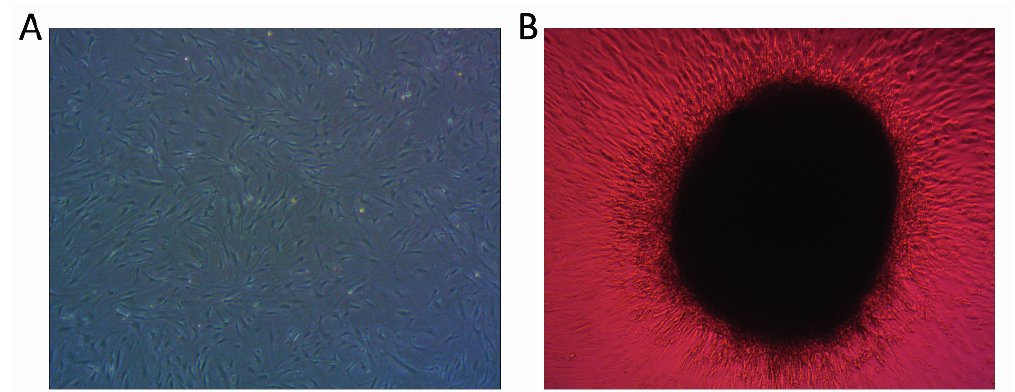
Figure 8. ( A ) Human MSCs were expanded in monolayer culture (40×) and ( B ) Cell